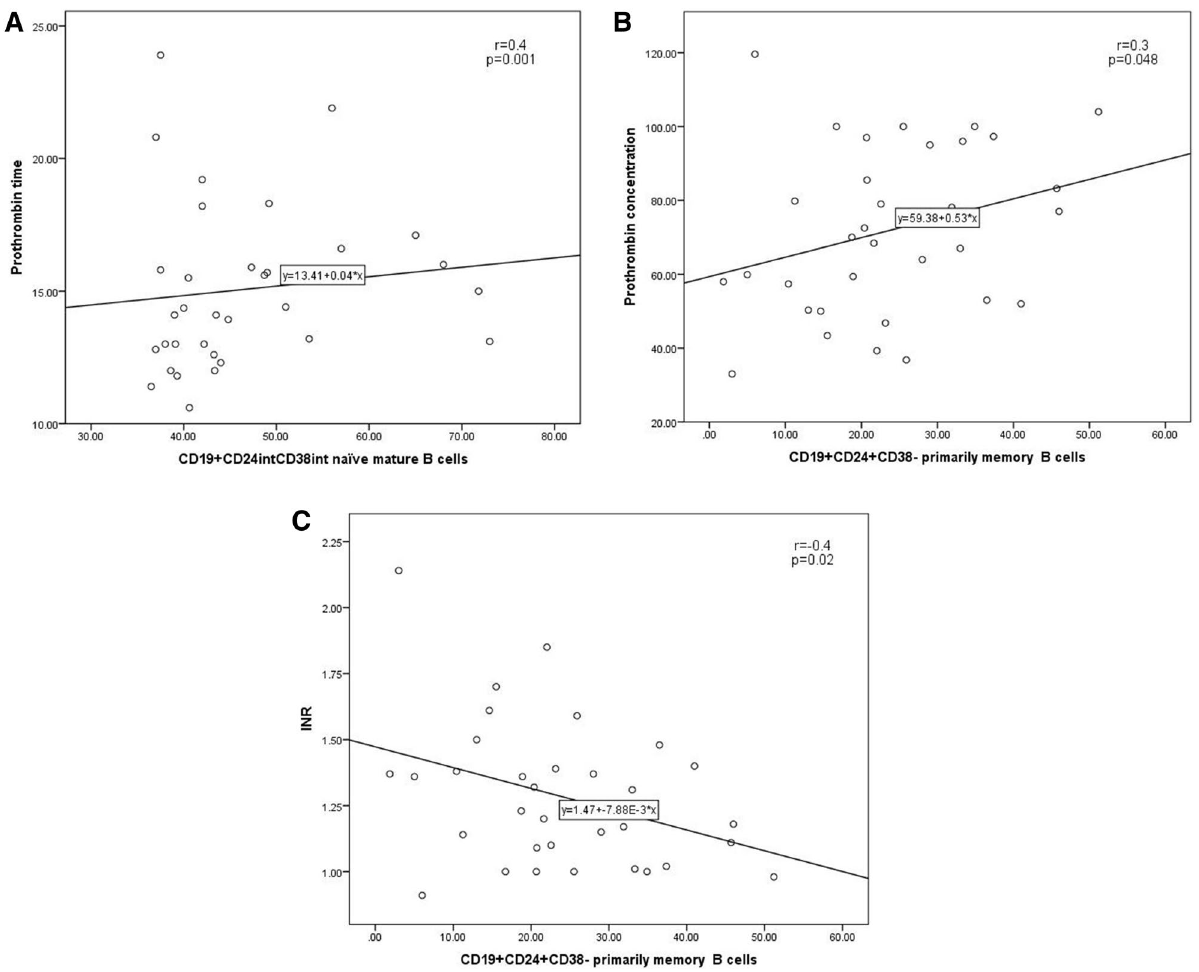
Figure 3. ( A ) Correlations of CD19 + CD24 int CD38 int naïve mature B cells with prothrombin time and correlations of CD19 + CD24 + CD38 − primarily memory B cells with ( B ) prothrombin concentration and ( C ) INR in the diabetic CHC patients.